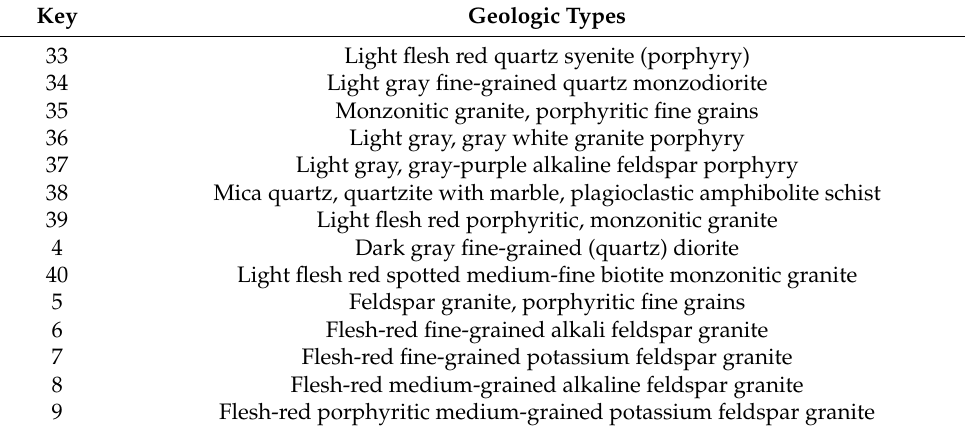
Table A1. Cont. Key Geologic